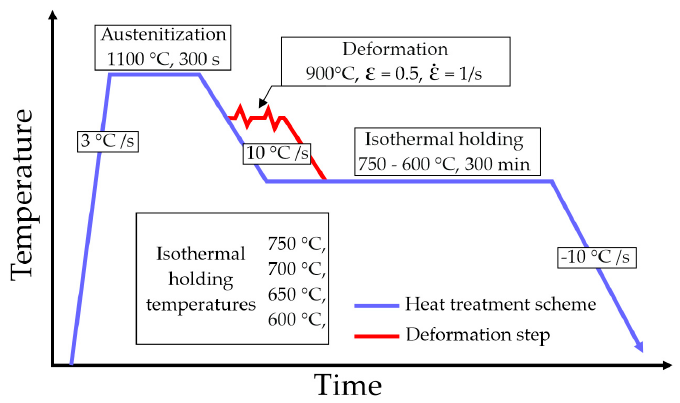
Figure 1. Schematic of heat treatments performed during the tests. Table 2. Critical temperatures of the tested alloy.